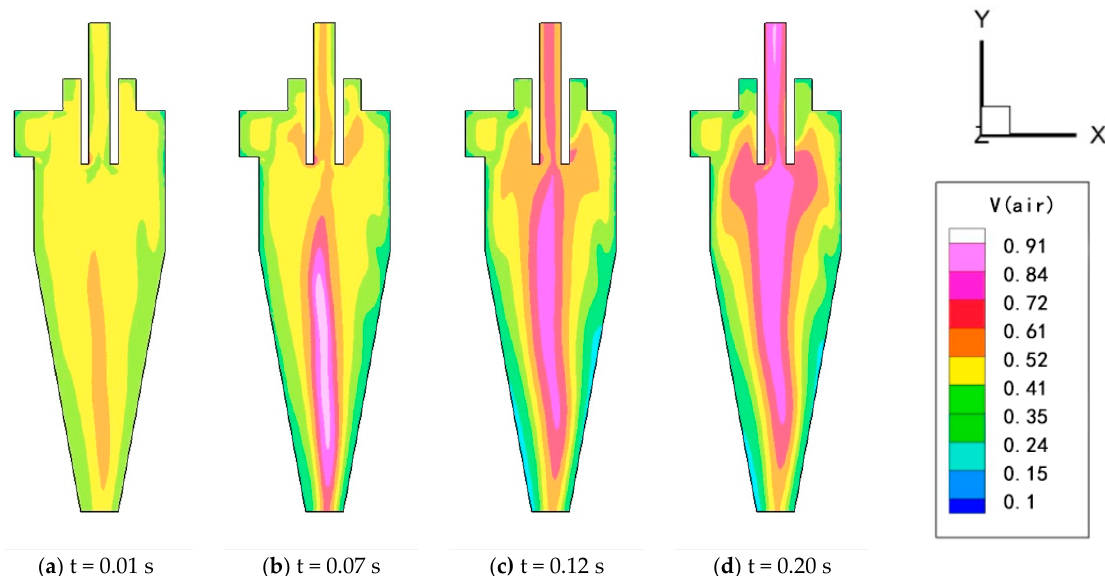
Figure 11. Simulation of bubble flow in cyclone.